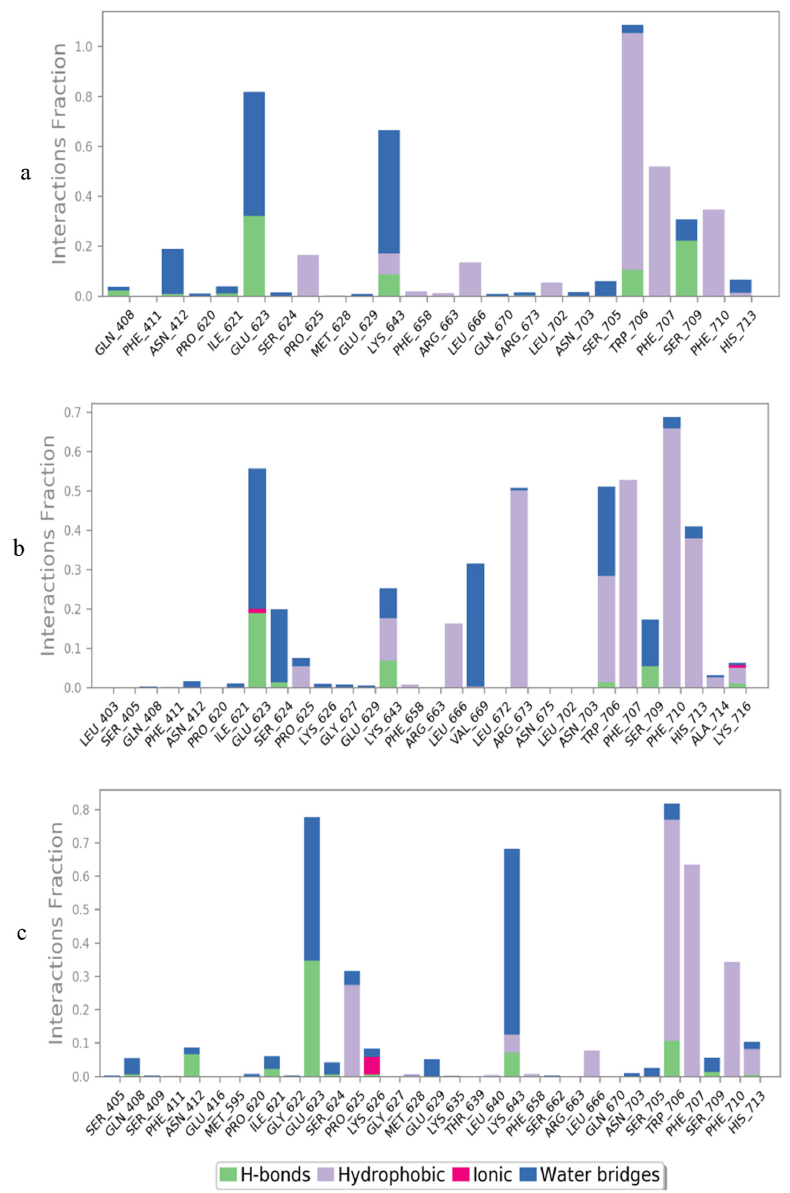
Figure 12. Protein-ligand contacts during the 100ns MD simulations. ( a ) Interaction fraction of complex G07 -3CM8. ( b ) Interaction fraction of complex G19 -3CM8. ( c ) Interaction fraction of complex G23 − 3CM8.